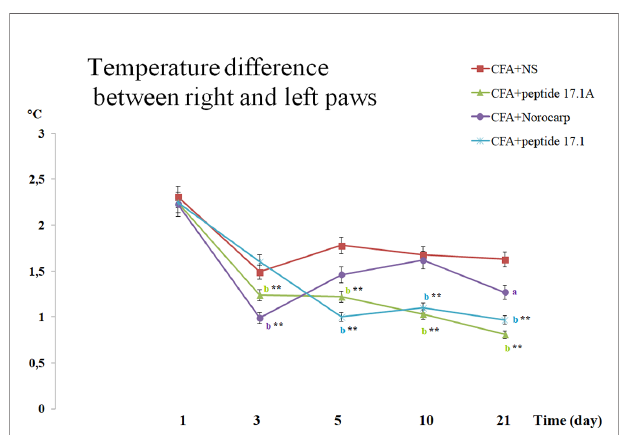
FIGURE 6 | Assessment of the temperature difference between the right (intact) and the left (arthritic) paws in CFA-induced arthritis in mice of control, CFA-control (treatment of NS), 17.1A, Norocarp, 17.1 (CFA, complete Freund ’ s adjuvant; NS, normal saline). All data are presented as mean ± SEM for at least three